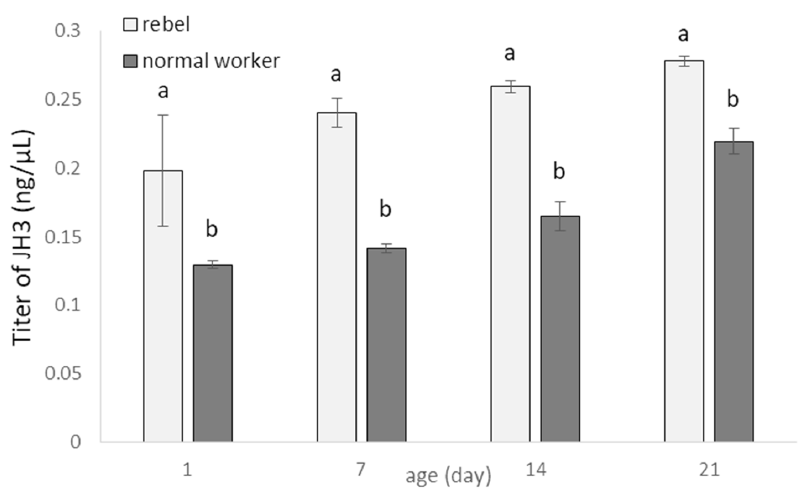
Figure 2. Phagocytic index (%; mean ± SD) in hemolymph of normal workers and rebels. Lowercase letters indicate significant differences between averages for the rebels and normal workers within a specific age with p < 0.01; No. of rebels = 60; no. of normal workers = 60. JH3 titers increased with age of normal workers and rebels (Figure 3). However, the rebels had higher JH3 levels compared to normal workers (Two-way ANOVA with mul- tiple comparison testing using the post hoc Tukey HSD test; age F (3,232) = 307.55, p < 0.0001; castes/sub-caste F (1,232) = 1531.2; p < 0.0001, post-hoc for each group max. p < 0.0001; castes/sub-caste*age F (3,232) = 1058.3, p < 0.0001, post-hoc for each group max. p = 0.880745; castes/sub-caste*age F (3,2320) = 22.550, p < 0.0001, post-hoc for each group max. p < 0.0399; no. of rebels = 60; no. of normal workers = 60). no. of rebels = 60; no. of normal workers = 60).